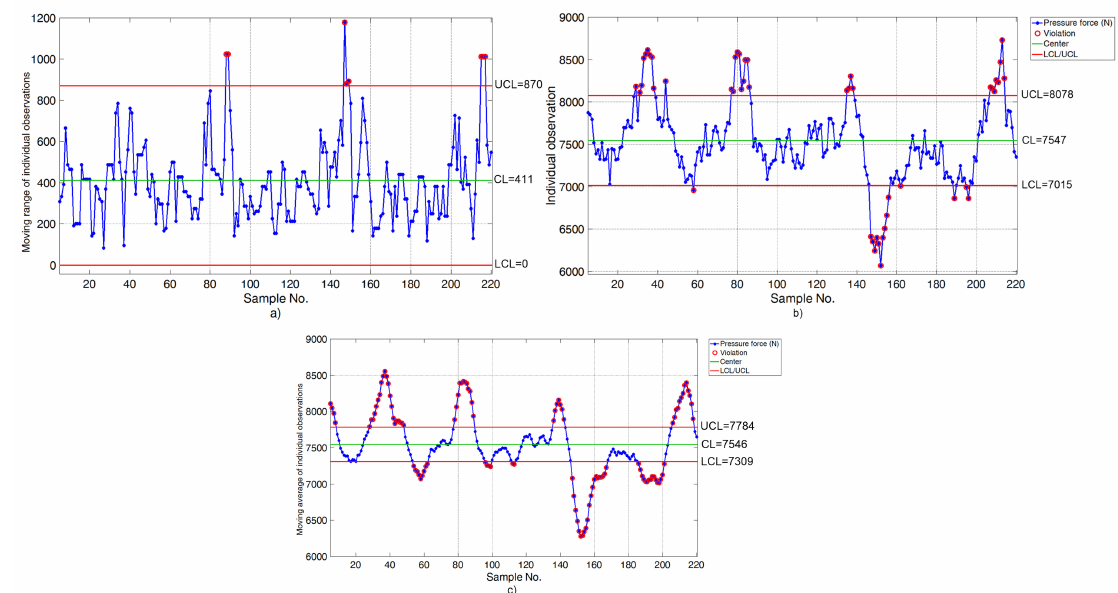
Figure 13. Control charts for technological parameter pressure force ( a ) diagram of moving range, ( b ) diagram of individual values, ( c ) diagram of moving